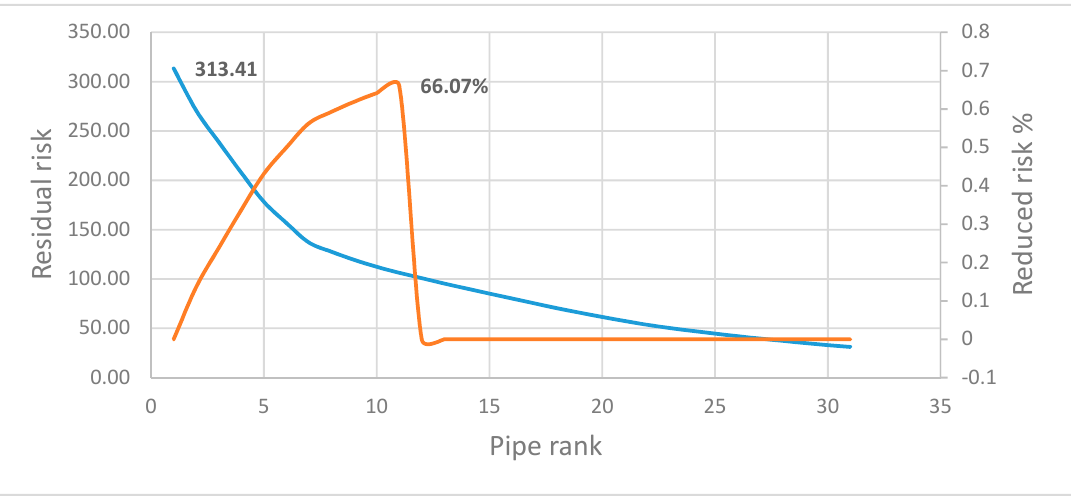
Figure 11. Cumulative risk reduction evaluated based on the target replacement percentage of pipe in the masterplan calculated for the first year